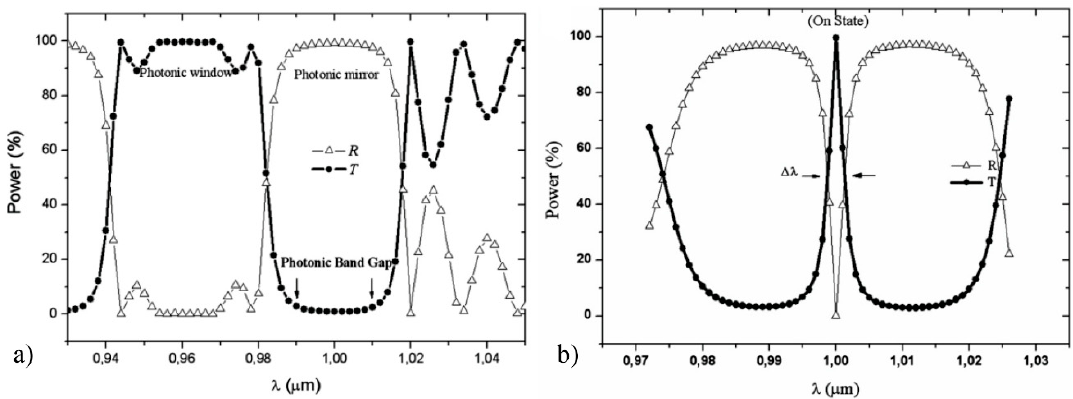
Figure 7. Transmitted (T) and reflected (R) power in a Photonic Crystal transducer [76], with permission of The Electromagnetics Academy. ( a ) Without any defect; ( b ) Applying a defect in the structure.